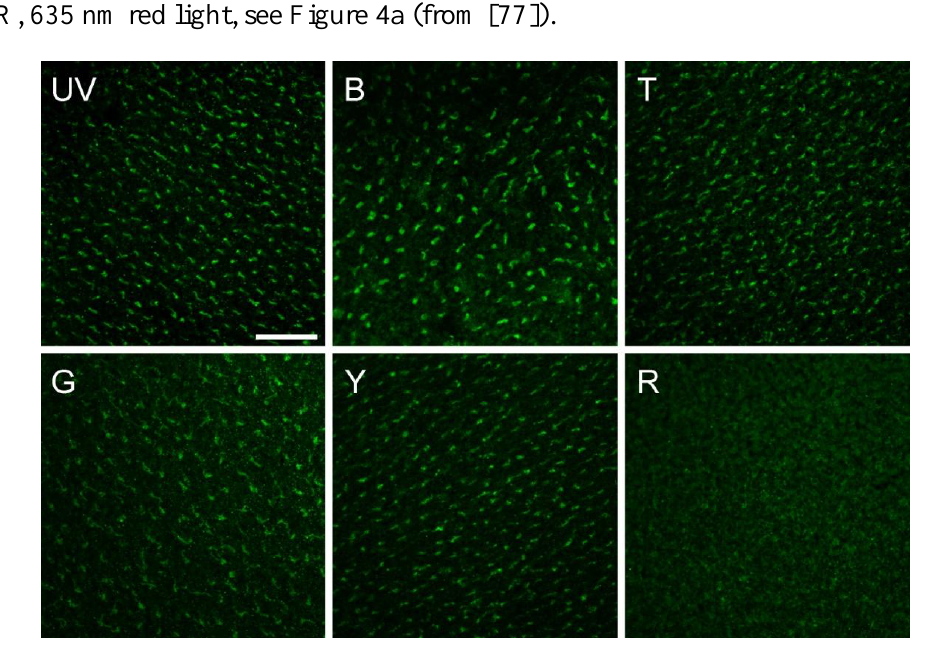
Figure 9. The amount of activated Cry1a, labeled with a specific antiserum, in the retina of chickens after illumination with light of various wavelengths. UV, 373 nm UV light; B, 424 nm blue light; T, 502 nm turquoise light; G, 565 nm green light; Y, 590 nm yellow light; R, 635 nm red light, see Figure 4a (from